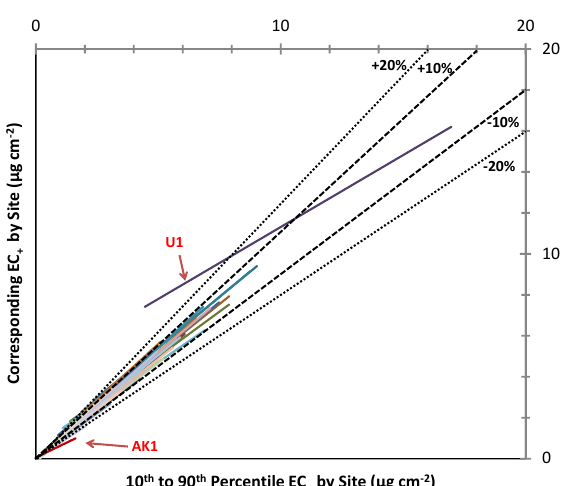
Fig. 6. EC + (after instrument upgrade) vs. EC − (before upgrade) relationships derived from robust regression analysis. Relationships of EC + and EC − with τ R are determined separately, and then EC + is related to EC − by eliminating τ R in simultaneous equations. Each solid line represents one of the 65 sites stretching from 10th to 90th percentile of EC − . Dashed lines indicate ± 10% or ± 20% devia-